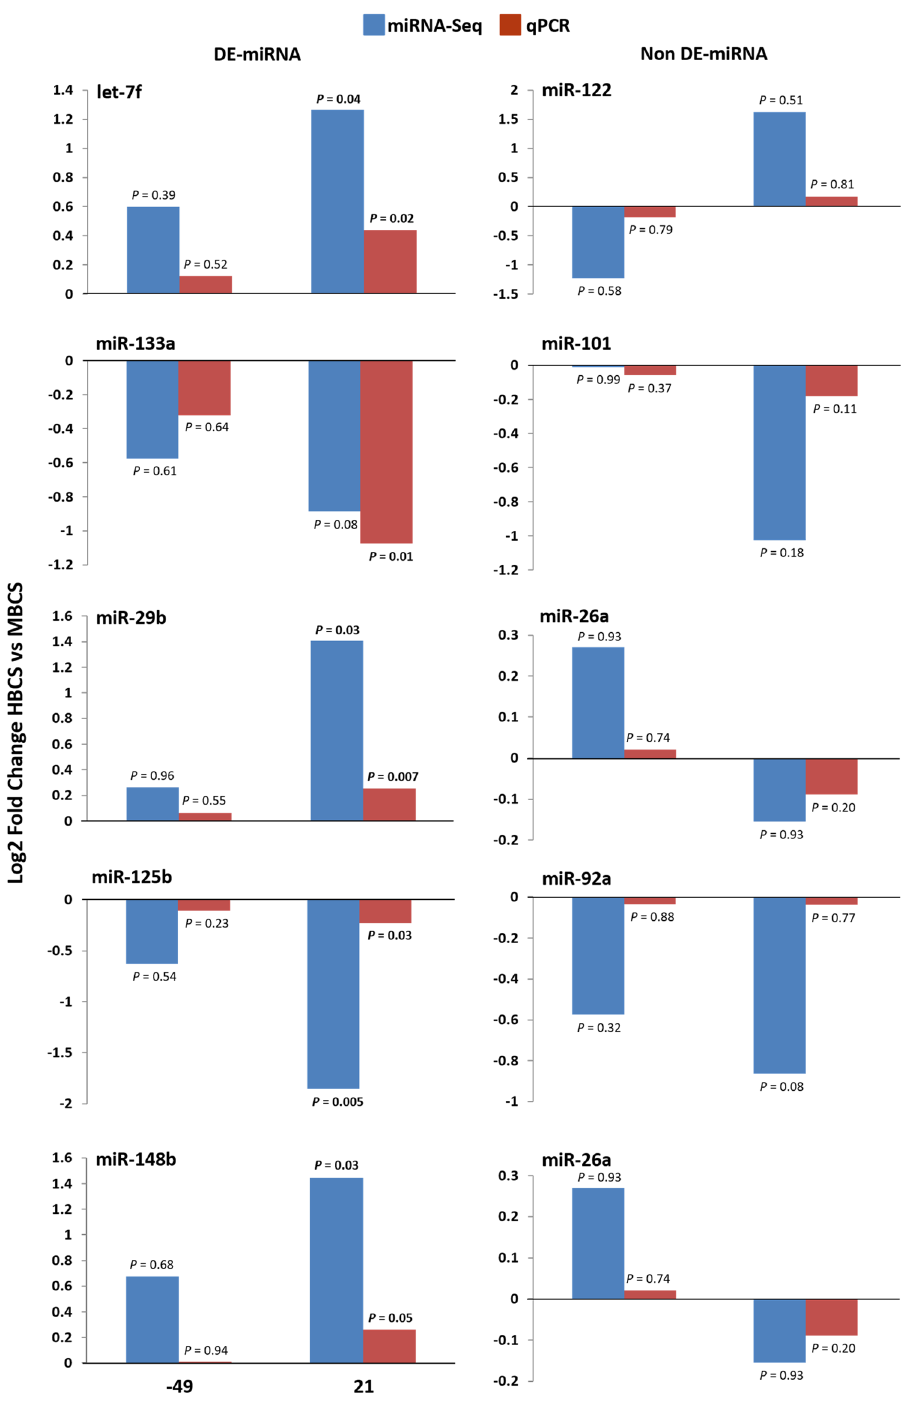
Figure 3. Comparison of the log2fold-change values obtained by either miRNA-Seq or RT-qPCR for five randomly selected differentially expressed (DE)-miRNA and five non DE-miRNA miRNA in high (HBCS) versus moderate-conditioned (MBCS) dairy cows on d -49 and 21 relative to calving. The y-axis represents the mean of log2fold-change value comparing HBCS versus MBCS n d -49 and 21. The level of significance was set at P < 0.05. The miRNA-seq results are based on pooled samples (4 pools containing each 4 animals per time point), whereas individual samples were used for the RT-qPCR